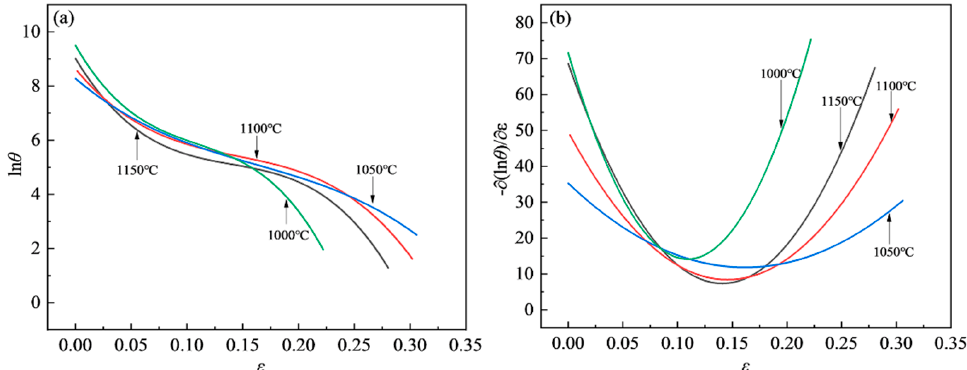
Figure 12. Relationship between ln θ − ε and − ∂ ( ln θ ) / ∂ε − ε for S280 steel at a strain rate of 1 s –1 and different deformation temperatures: ( a ) ln θ − ε ; ( b ) − ∂ ( ln θ ) / ∂ε − ε .